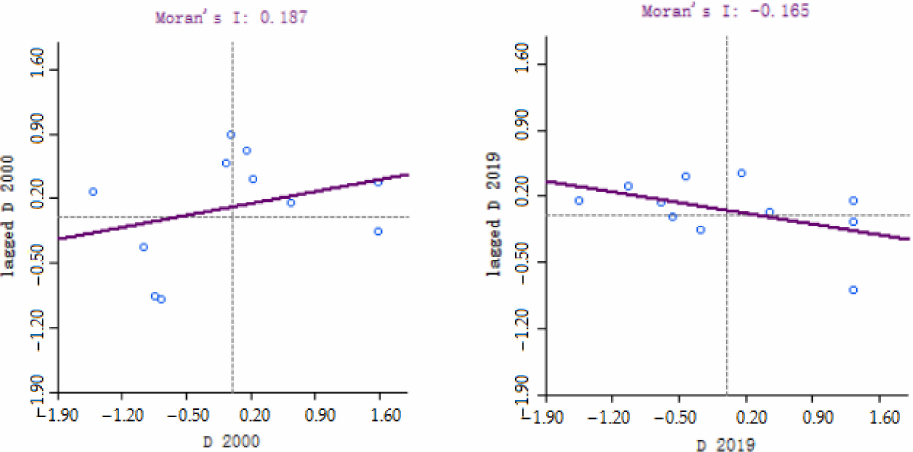
Figure 5. The spatiotemporal development characteristics of the coupling coordination degree.